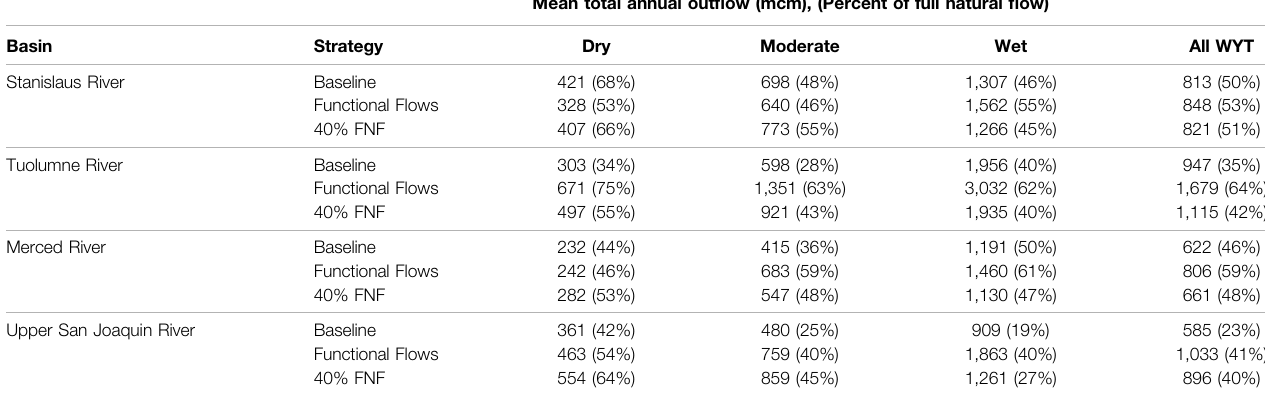
TABLE 3 | The mean total annual fl ow volume released for the base fl ow, 40% FNF, and functional fl ow strategies. Out fl ows include fl ood releases. Flow volumes are categorized by basin, strategy, and water year type (WYT).